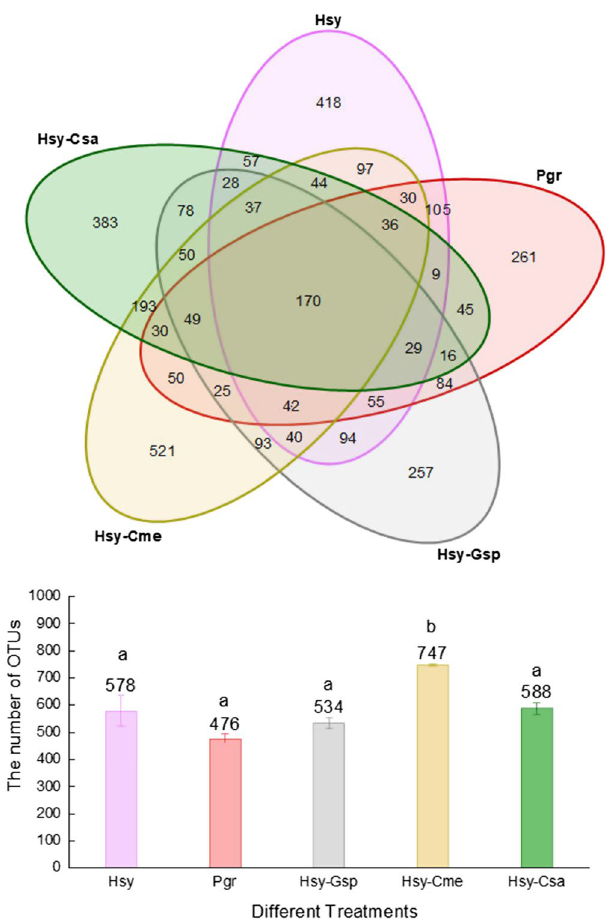
Figure 1. Venn diagram and bar chart of OTUs in Hsy, Pgr, Hsy-Gsp, Hsy-Cme and Hsy-Csa. The numbers in overlapping regions represent the number of OTUs shared by treatments. The numbers in nonoverlapping regions represent the number of unique OTUs in each treatment. The numbers above the bars represent the average number of OTUs in different treatments. Different lowercase letters above the bars indicate significant differences in the number of OTUs among treatments (P <